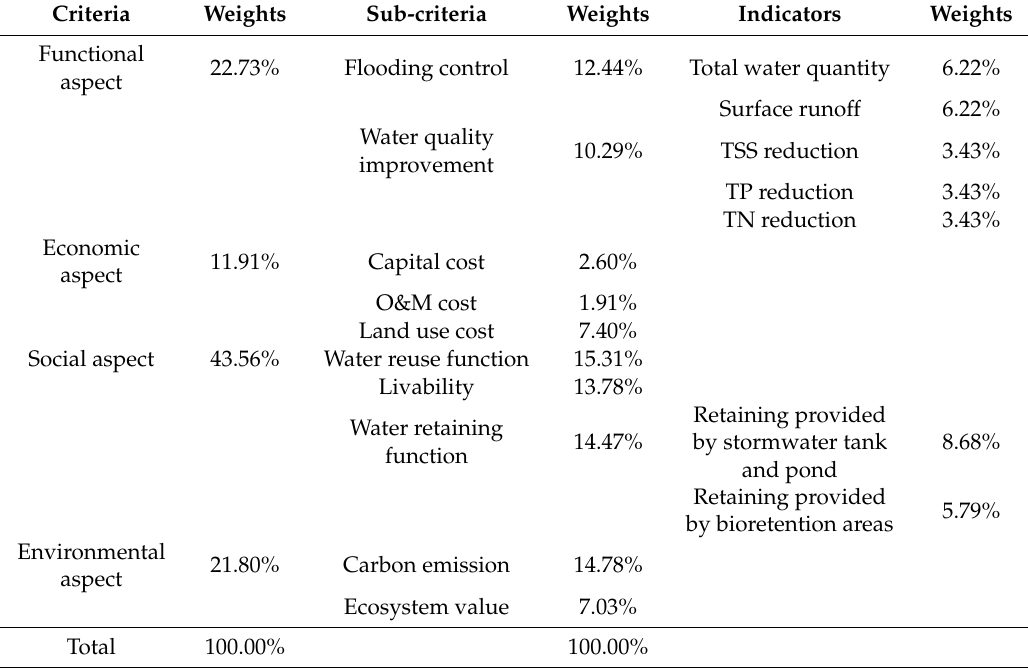
Table 9. The weights of criteria, sub-criteria, and